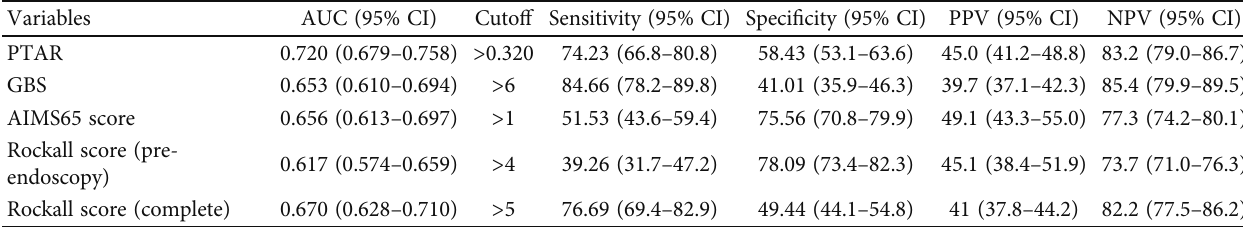
Table 3: Predictive variables of ICU